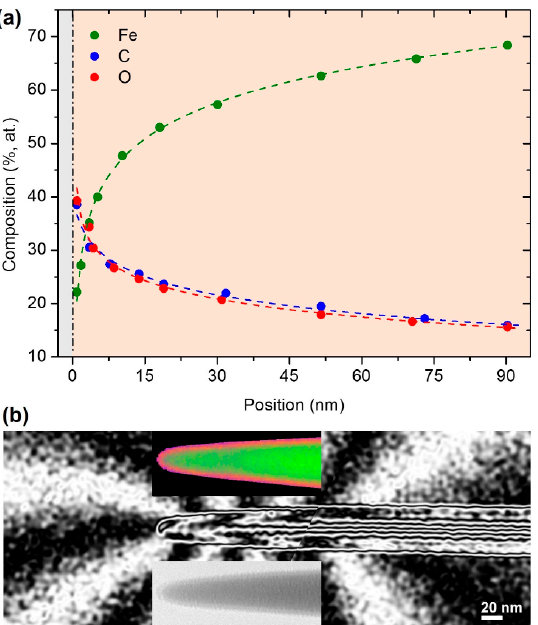
Figure 4. ( a ) Longitudinal chemical profile of an Fe nanowire grown on top of an AFM probe, obtained by STEM-EELS. The vertical short dash dot line represents the nanowire apex. ( b ) Representation of the magnetic flux lines illustrating the stray field distribution, obtained experimentally by electron holography, including insets with the TEM image (bottom), and the chemical map showing the relative composition of Fe, C, and O contents in green, blue, and red, respectively (top). Adapted from [61] and reproduced from [41] with permission from the Royal Society of Chemistry.